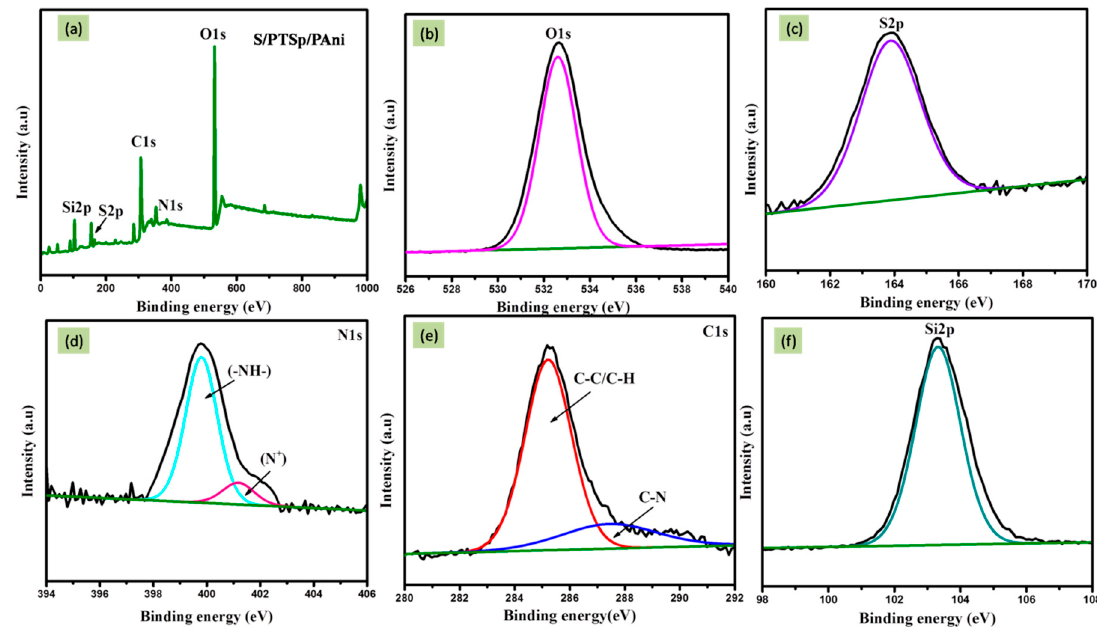
Figure 6. ( a ) Wide spectrum of composite material (sublimed sulfur / post-treated sepiolite / PAni), XPS Spectra of ( b ) oxygen, ( c ) sulfur, ( d ) Nitrogen, ( e ) carbon, ( f ) silicon.